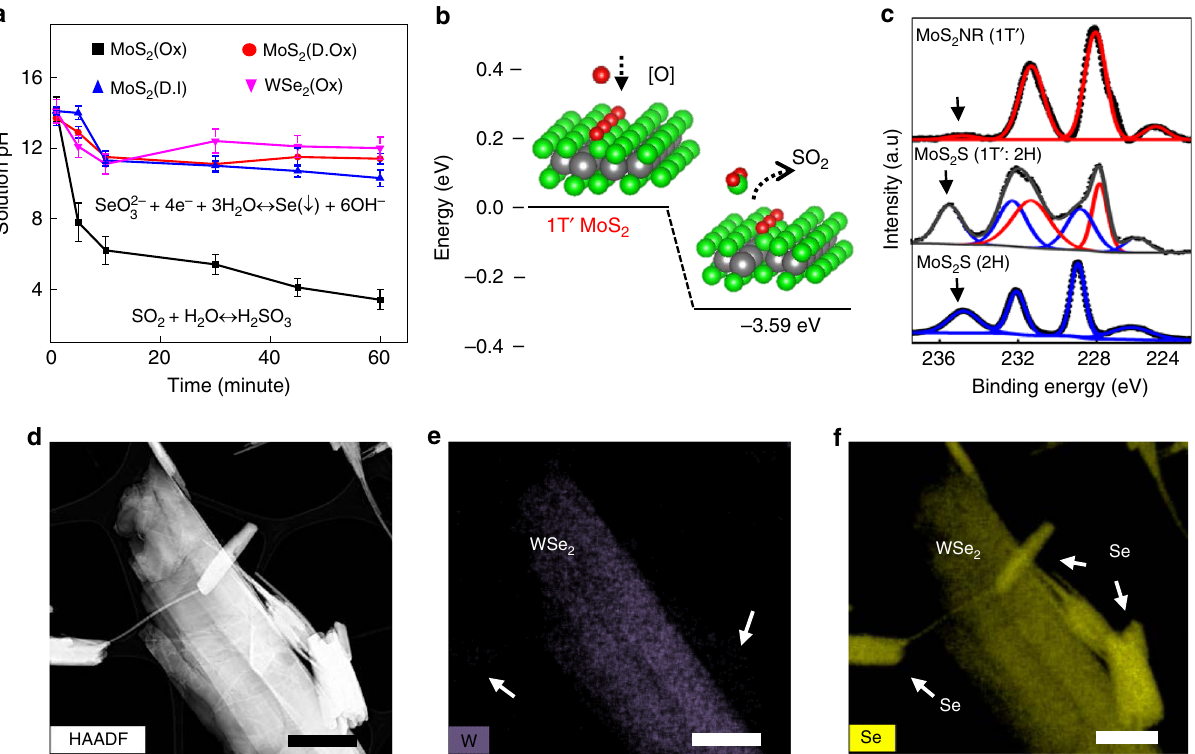
Fig. 3 Mechanism for longitudinal unzipping. a Solution pH changes upon the ultrasonication of Li intercalated MoS 2 in oxygenated (Ox), deoxygenated (D.Ox), and deionized (D.I) water. Solution pH change upon hydration of Li intercalated WSe 2 in oxygenated water is also provided. b Schematic presentation of energetically favored removal of SO 2 from MoS 2 surface. c XPS analyses of Mo3d orbits of MoS 2 sheets of pure 2H phase and 2H:1 T ′ combined phase and MoS 2 NRs prepared in oxygenated water. d – f HAADF and Elemental mapping (W, and Se) of partially unzipped WSe 2 layered sheet displaying Se as a byproduct and line defects on the basal plane. Scale bars, 0.2 µ